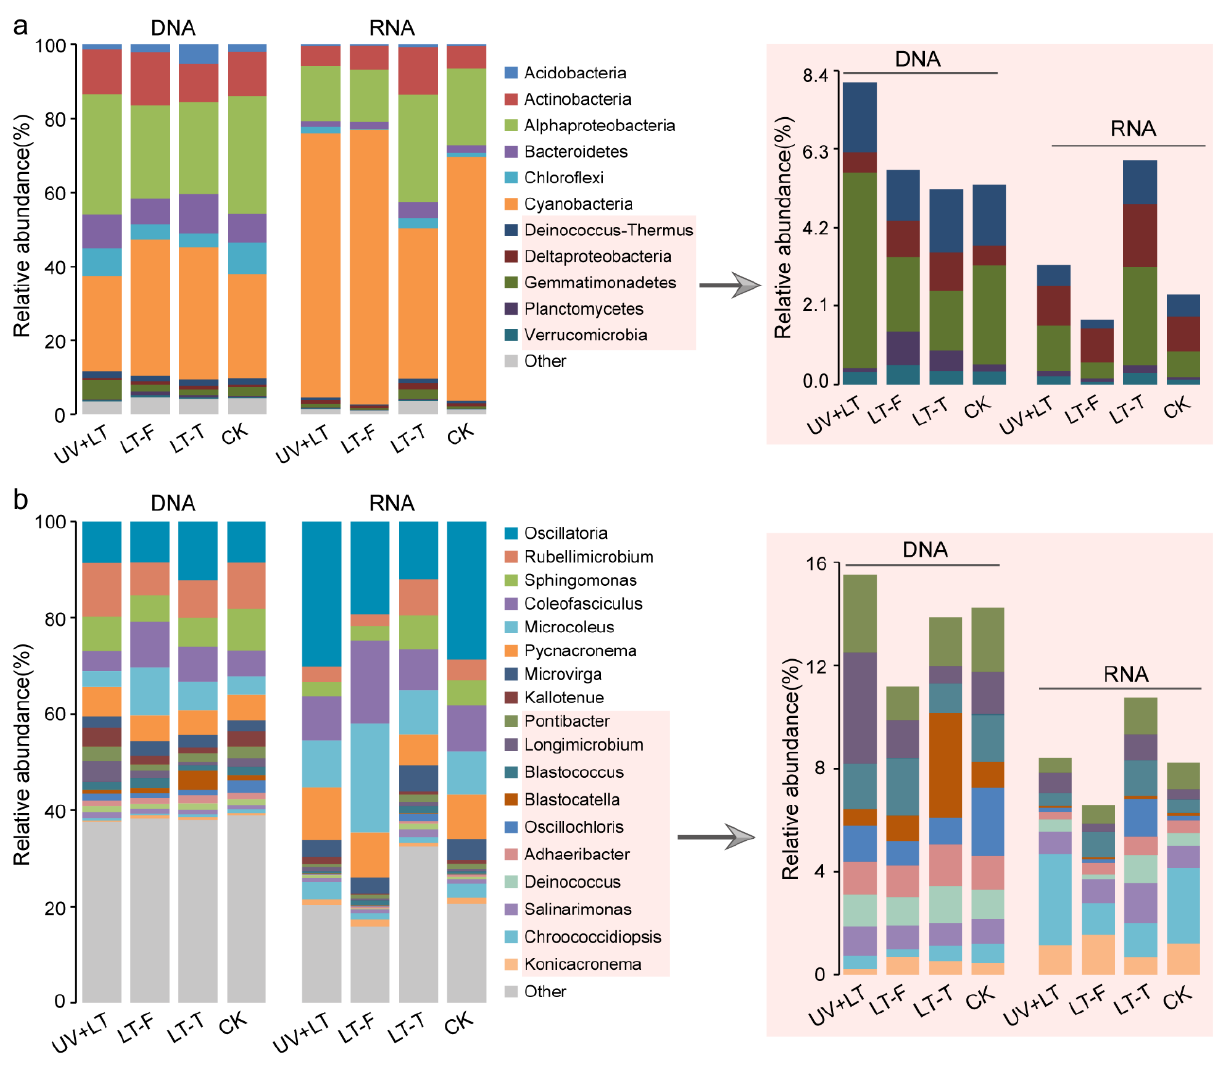
Figure 4. Bacteria community composition on phylum (or class for the Proteobacteria) ( a ) and genus ( b ) level. The right figures show the relative abundance of taxa in the mistyrose box. UV + LT: stratospheric exposure; LT-F: low-temperature freezing; LT-T: low-temperature thawing; CK: natural control. The relative abundances of different genera (average relative abundance >